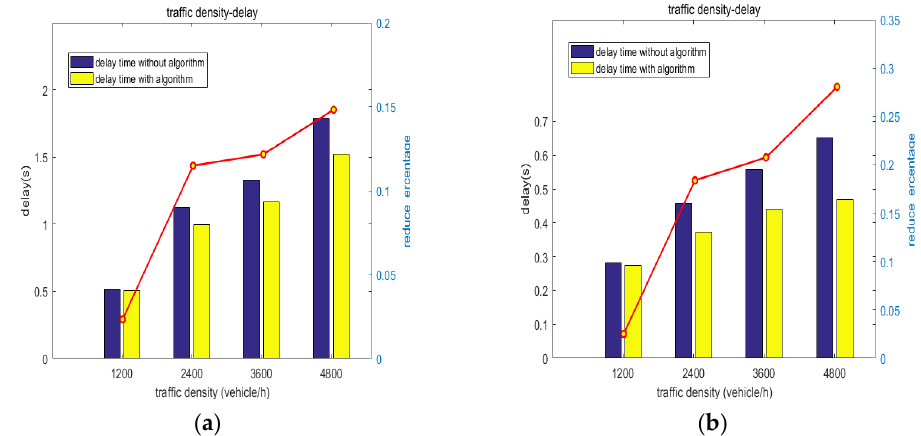
Figure 10. Comparison of delay with coordination strategy and without coordination strategy in different traffic densities: ( a ) intersection 5 and ( b ) intersection 6.